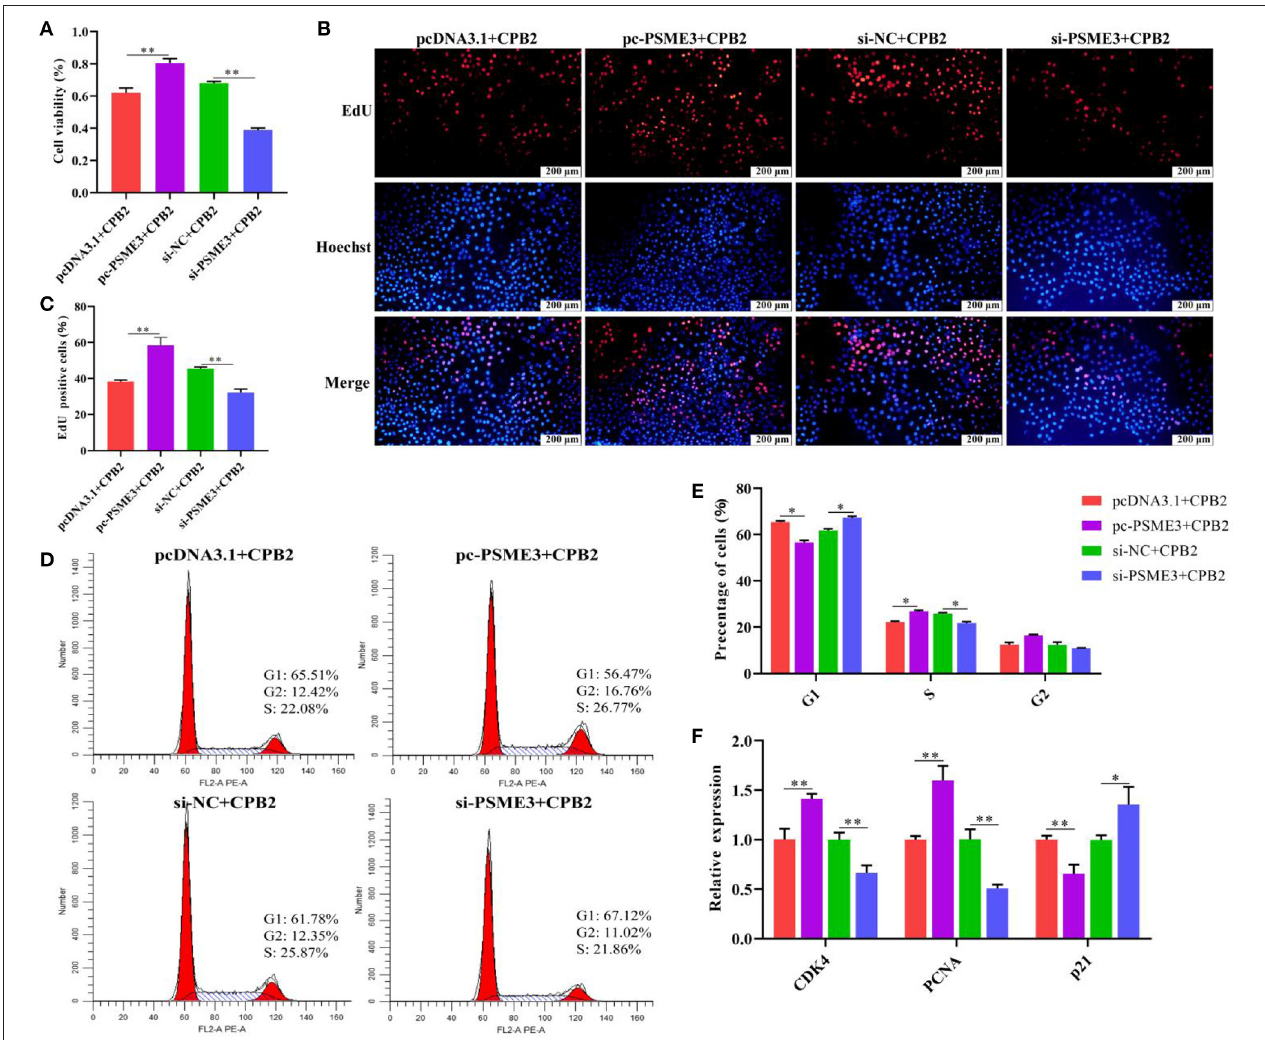
FIGURE 6 | PSME3 promoted cell proliferation and cycle progression in the CPB2 toxin revulsive IPEC-J2 cells. (A–F) The IPEC-J2 cells were transfected with pcDNA3.1, pc-PSME3 (1 µ g), si-NC, and si-PSME3 (150nM), and treated with CPB2 toxin for 36h. (A) Cell viability was tested via CCK-8 on a microplate reader at 450nm. (B) The EdU assay was performed. The IPEC-J2 cells in S-phase were stained red with EdU, whereas the nucleus was dyed blue with Hoechst. (C) Image J analysis of the proportion of proliferating cells. (D,E) Flow cytometry analysis of the IPEC-J2 cell cycle. (F) qPCR analysis of CDK4 , PCNA , and p21 expression. * p < 0.05, ** p <